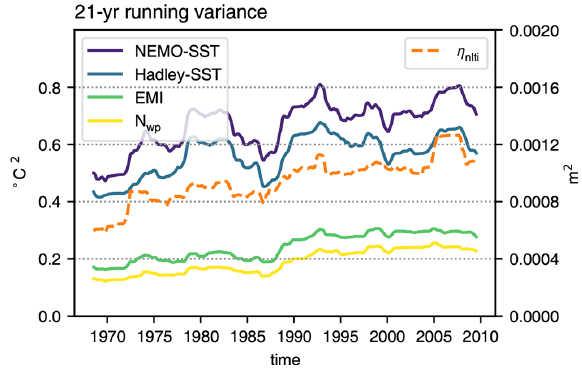
Figure 5. Variance in running 21-year windows of time series of different indices averaged along the Equator between 160 ◦ E and 150 ◦ W, corresponding to the Niño4 region and computed using monthly mean anomalies. NEMO-SST refers to SST taken from the NEMO model simulation and Hadley-SST to SST taken from the HadISST dataset. The units are ( ◦ C) 2 (left axis), except for the index based on η nlti , which has units m 2 (right axis).